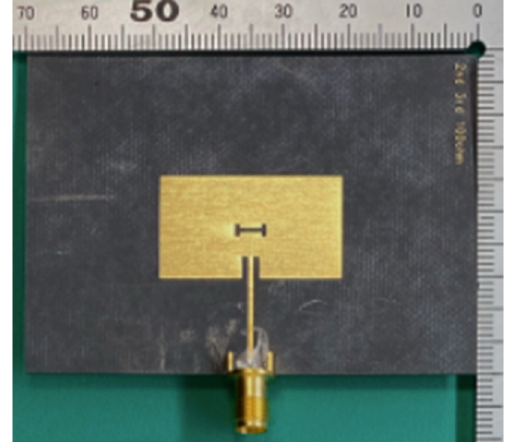
Figure 11. Photograph of the fabricated antenna.